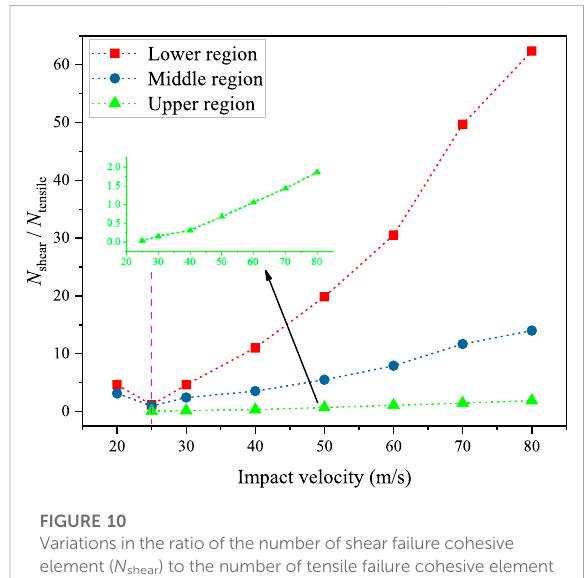
FIGURE 10 Variations in the ratio of the number of shear failure cohesive element ( N shear ) to the number of tensile failure cohesive element ( N tensile ) in different regions of rock sample under different impact